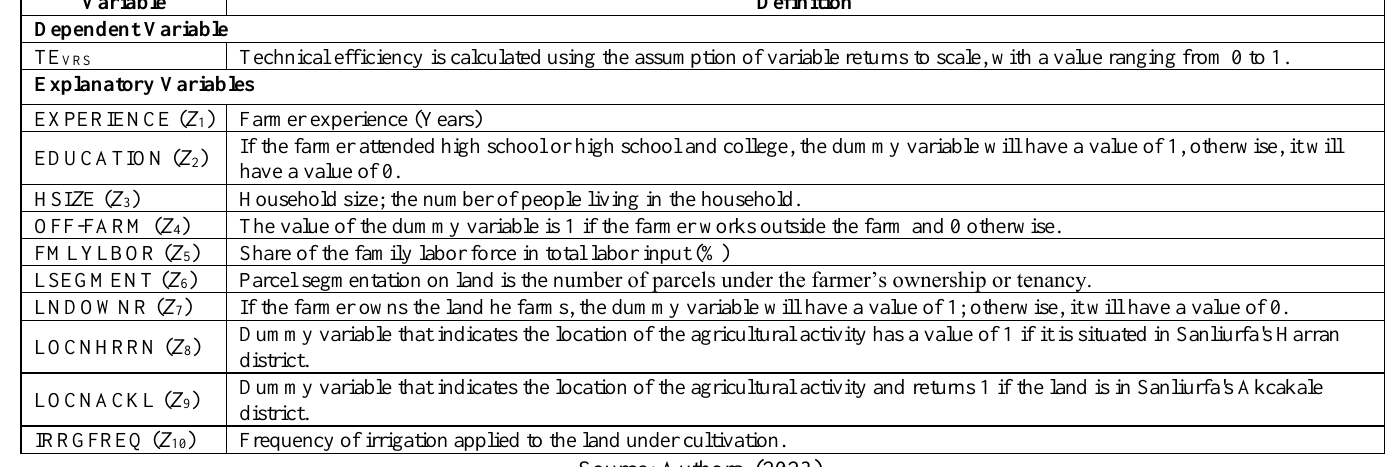
Table 2: Z variables’ definition for the stochastic frontier analysis (inefficiency determinants).